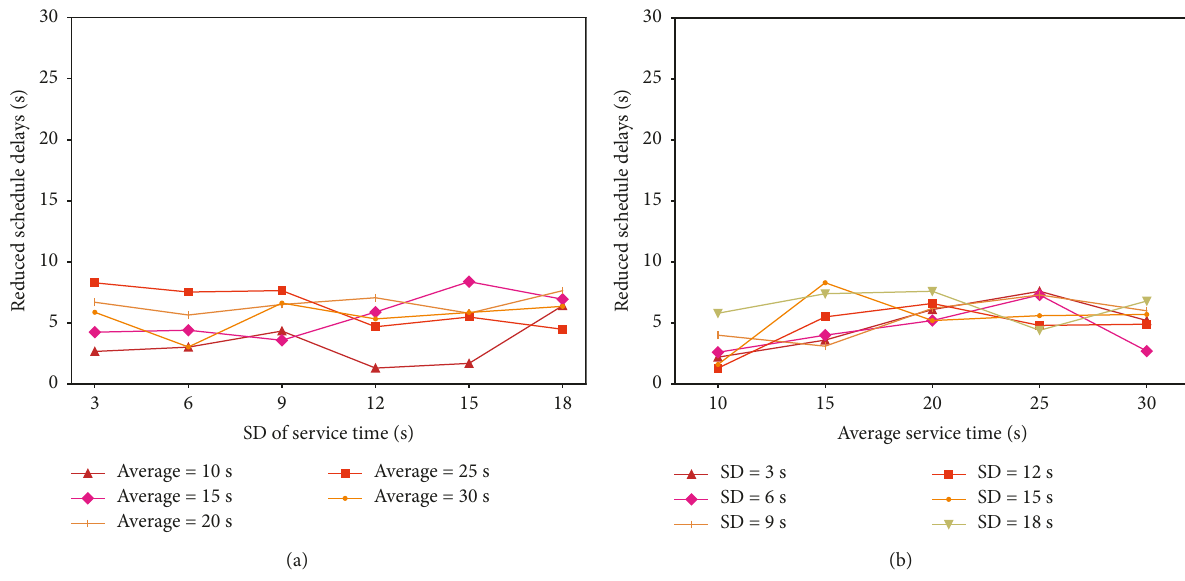
Figure 11: Impacts of service time on schedule delay: (a) SD of service time and (b) average service